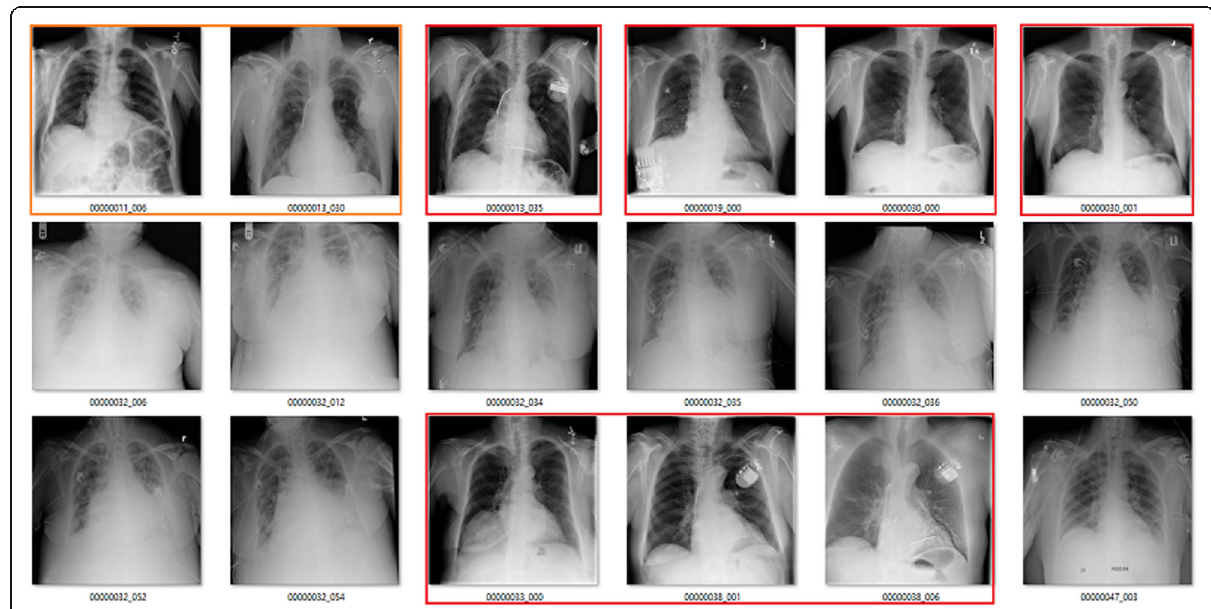
Fig. 1 Images from the ChestXray14 dataset labelled as showing atelectasis (red boxes indicate wrong label, orange indicate doubtful). Courtesy of Luke Oakden-Rayner (available at: https://lukeoakdenrayner.wordpress.com/2017/12/18/the-chestxray14-dataset-problems/) , with